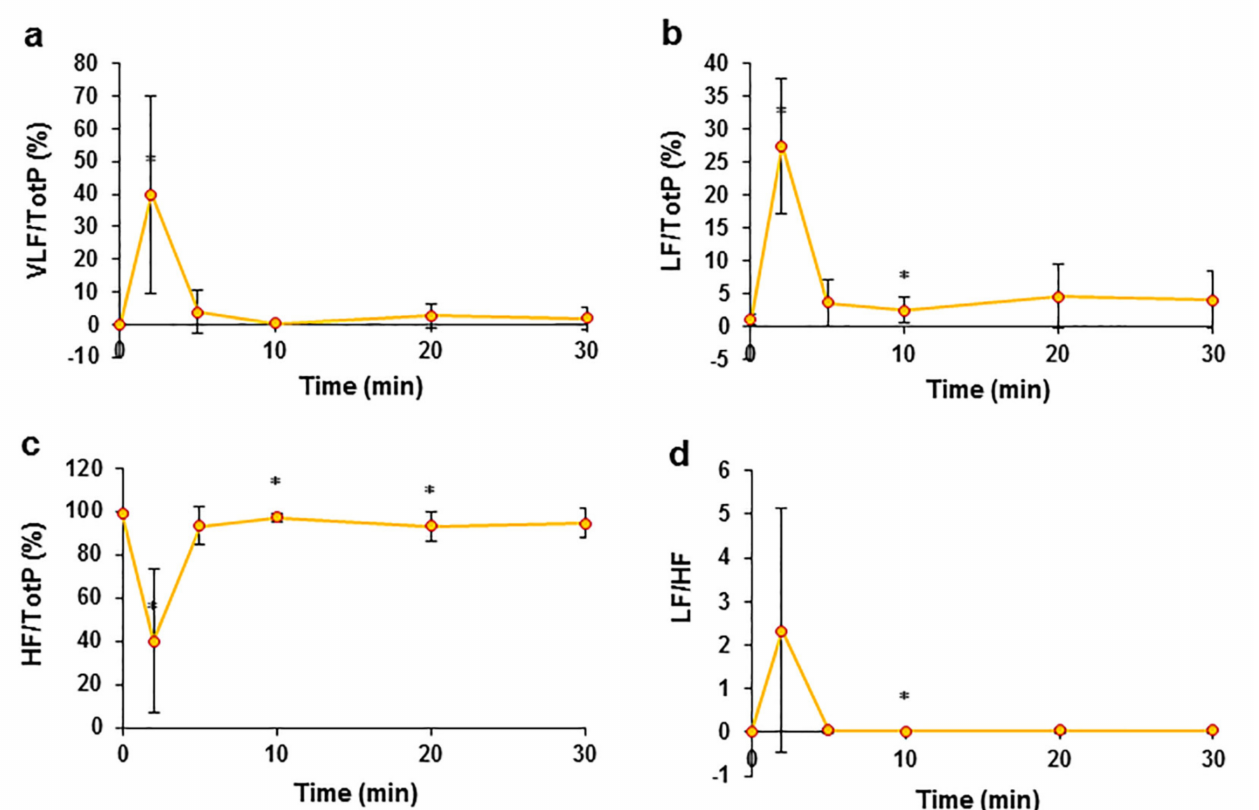
Figure 4. The effects of an intravenous injection of an EO bolus on the frequency domain of pig HRV. Ratio of very low frequency power (VLF) to total power of frequency (Tot P) ( a ), changes in the ratio of the LF component to total frequency power ( b ), changes in the ratio of HF to total frequency power changes after the administration of the EO bolus ( c ), and LF/HF ( d ). * p < 0.05 indicates at significant difference compared to the control, n =